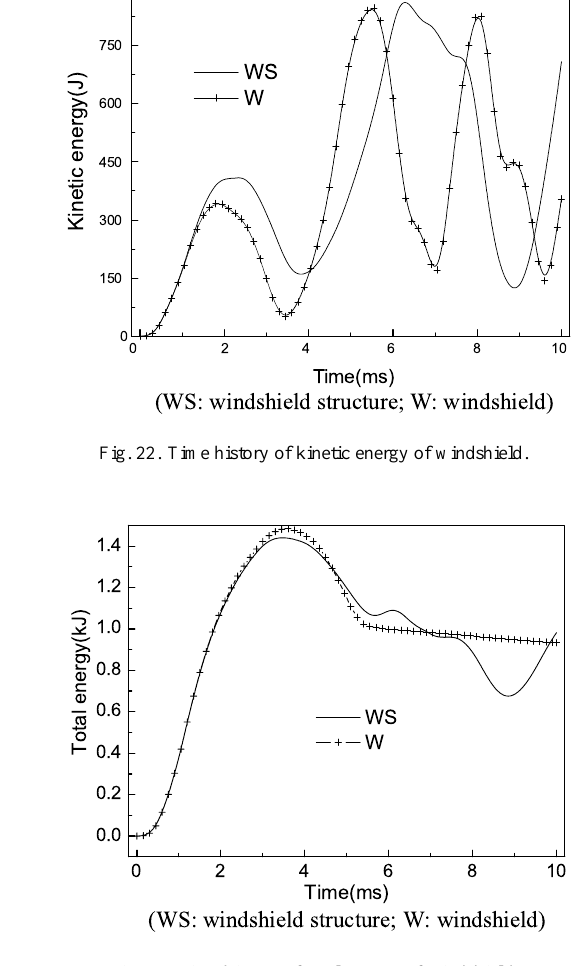
Fig. 23. Time history of total energy of